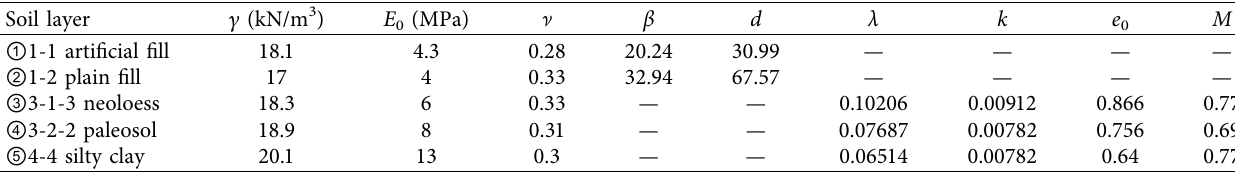
Table 2: Soil basic physical property index.